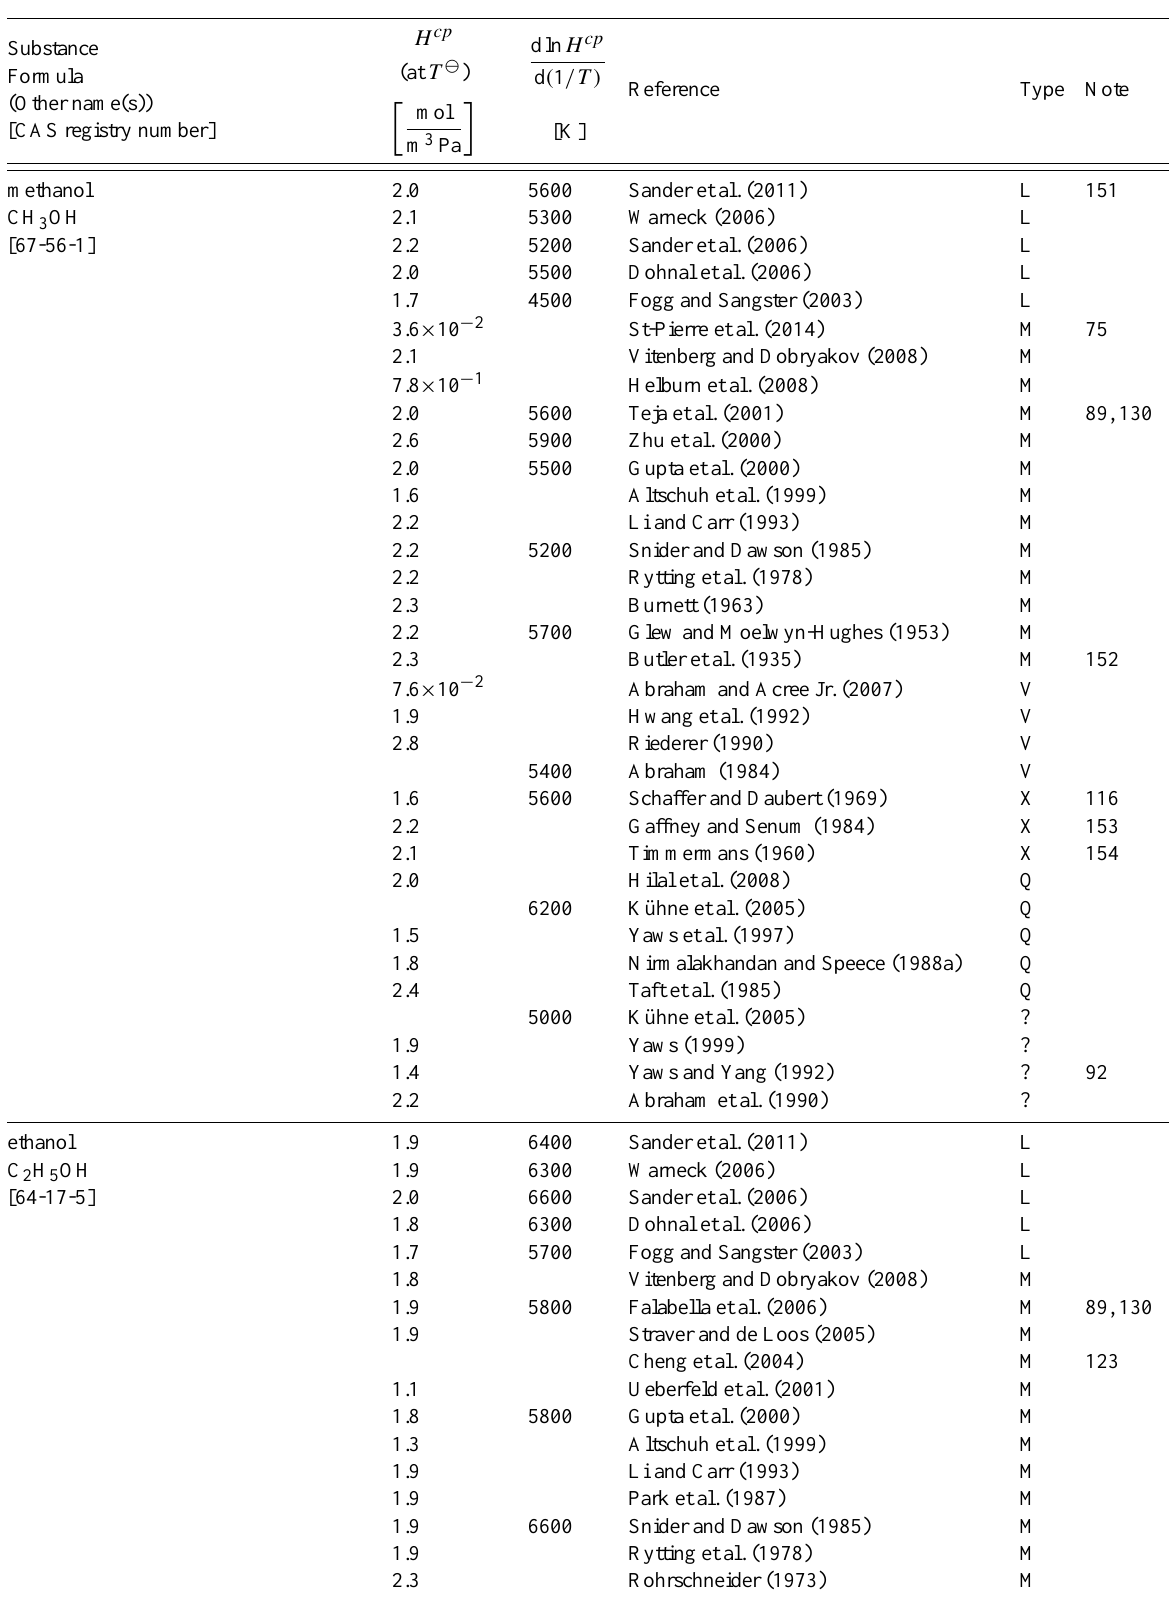
Table 6: Henry’s law constants for water as solvent